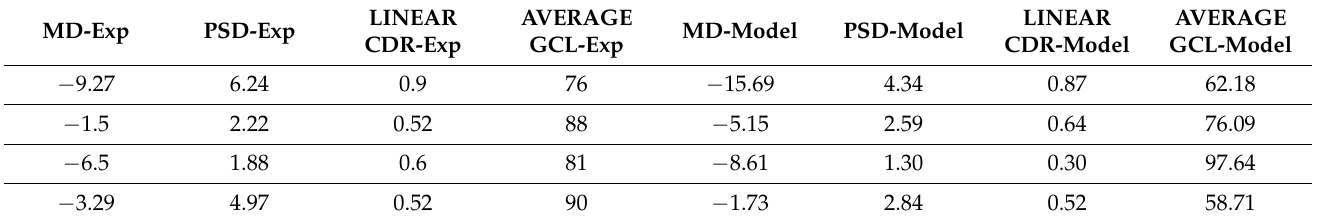
Table 3. Data on new patients not previously used by the